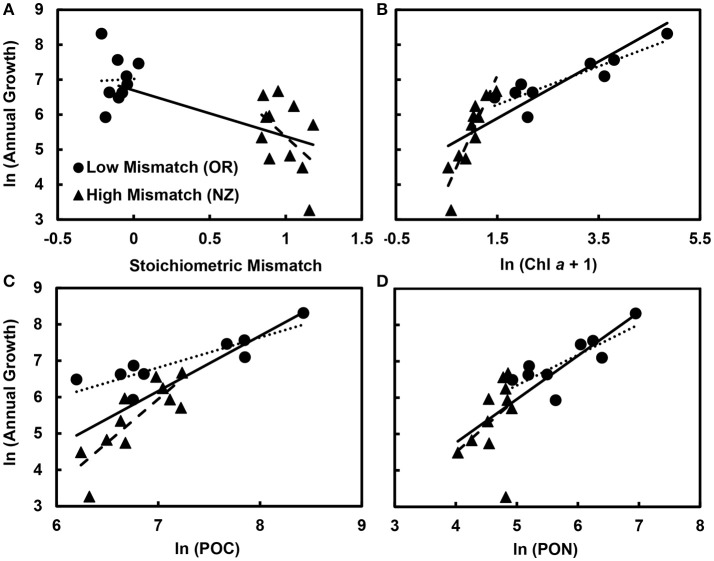
Effects of resource availability and stoichiometric mismatch on mussel growth. Across both regions, growth (originally measured in mg g−1 yr−1) declined with (A) stoichiometric mismatch (p = 0.001) and increased with (B) phytoplankton availability (Chl a, originally measured in μg L−1; p < 0.001), (C) particulate organic carbon (POC, originally measured in μg L−1; p < 0.001), and (D) particulate organic nitrogen (PON, originally measured in μg L−1; p < 0.001). Within regions, for (B) Chl a (“Mismatch × Chl a” interaction, p < 0.001) and (C) POC (“Mismatch × POC” interaction, p = 0.005), the effect of resource quantity on growth was stronger in New Zealand, where stoichiometric mismatch was high, than in Oregon, where mismatch was low, so the slopes differed. However, for (D) PON (“Mismatch × PON” interaction, p = 0.138), the effect of resource quality on growth did not differ between regions. Data points are mean values for each site. Solid trendlines indicate relationships across both regions, dotted trendlines indicate relationships across Oregon sites, and dashed trendlines indicate relationships in New Zealand.